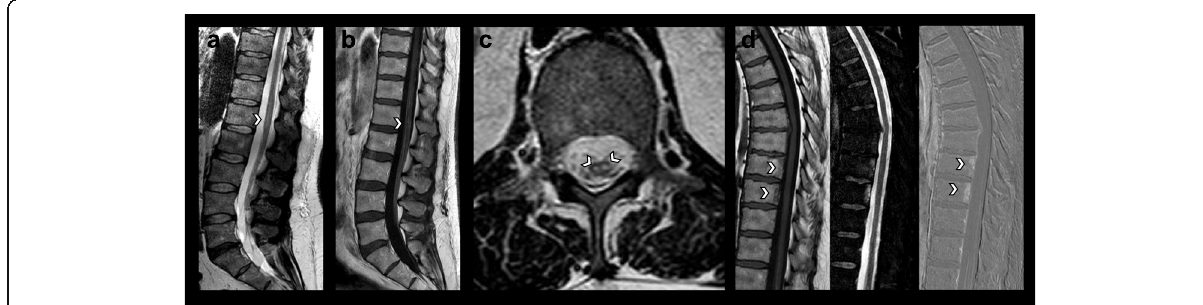
Fig. 2 Contrast-enhanced follow-up MRI performed 4 weeks after symptom onset. a Sagittal T2-weighted image showing vertical linear foci of high T2-weighted signal located anteriorly within the lower spinal cord (arrow). b Sagittal T1-weighted image after contrast injection demonstrating newly occurred intramedullary contrast enhancement (arrow) and persisting enhancement of the conus medullaris and descending nerve roots. c Axial T2-weighted image revealing bilateral circular foci of high T2-weighted signal in the anterior portion of the spinal cord at L1 level (arrows), also referred to as owl-eyes sign, suggestive of a mature infarction. d Sagittal T1-weighted image without contrast mean (left), sagittal T2-weighted fat-suppressed image (middle) and sagittal T1-weighted subtraction image after gadolinium-based contrast mean injection subtracted by the native T1-weighted image showing focal oedema in the posterior portion of the Th9 and Th10 vertebral bodies